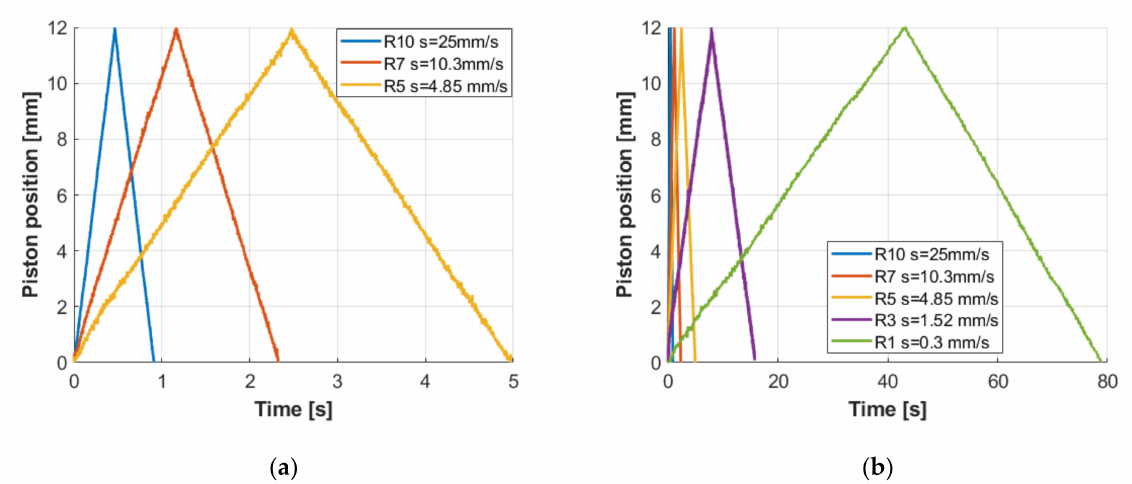
Figure 13. Piston position as a function of time: ( a ) comparisons among low and medium resistance configurations; ( b ) comparisons among low, medium, and high resistance configurations. For each resistance configuration, the correspond- ing speed value (s) is